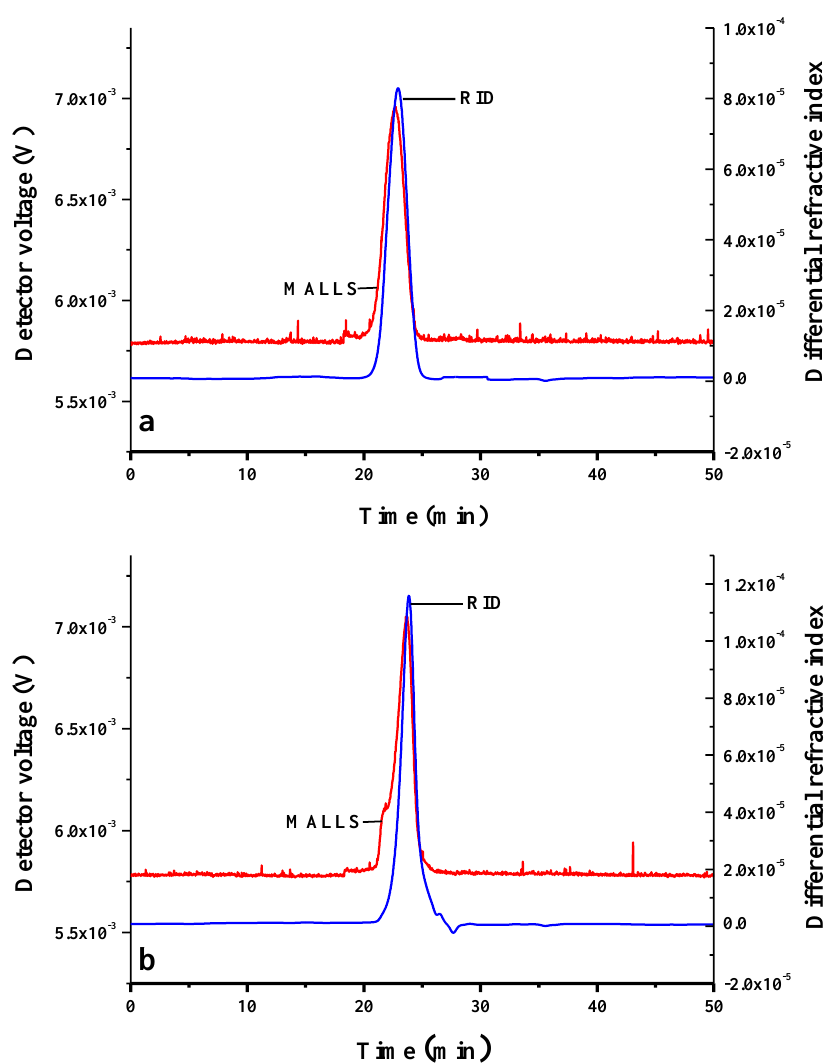
Figure 4. Gel permeation chromatography (GPC) chromatograms of inulin ( a ) and CMI ( b ).